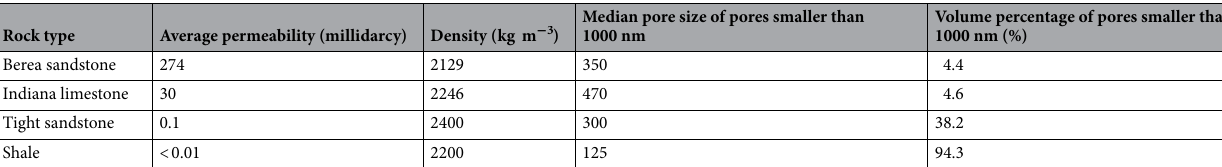
Table 3. Average permeability, rock density, and pore volume percentages of various rock types 20 .